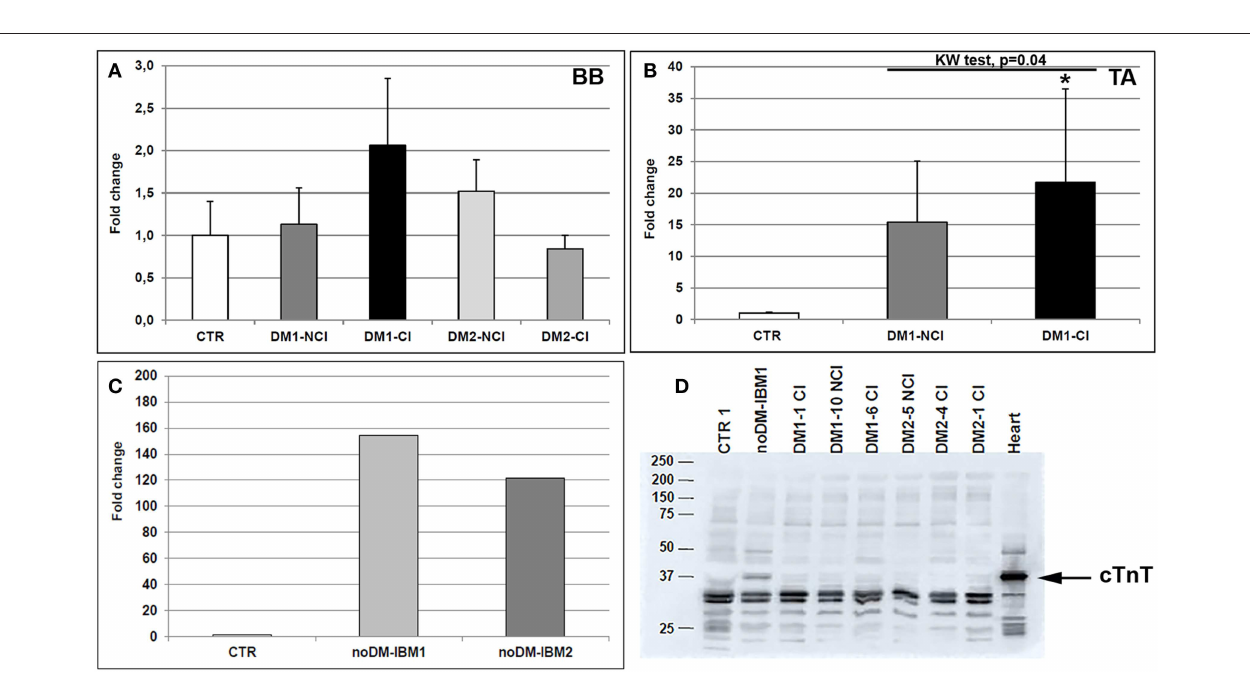
FIGURE 2 | (A–D) mRNA and protein TNNT2 expression in skeletal muscle. TNNT2 gene expression measured by qRT-PCR in biceps brachii (BB) muscle samples (A) and tibialis anterior (TA) muscle samples (B) from CTR (BB = 6; TA = 4), DM1 (BB = 12; TA = 12), and DM2 (BB = 9) patients. DM1 and DM2 patient groups have been divided into two subgroups according to the presence of cardiac abnormalities: NCI, no cardiac involvement; CI, cardiac involvement. The expression level of TNNT2 has been quantified in skeletal muscle (vastus lateralis) of patients affected by inclusion body myositis (noDM-IBM) (C) . Histograms represent mean values and bars represent standard error of the mean (SEM). GAPDH has been chosen as the housekeeping, internal control. Each PCR reaction has been performed in triplicate. The differences between subgroups have been assessed by nonparametric, Kruskal-Wallis test. Results from Dwass, Steel, Critchlow – Fligner multiple post-hoc comparison procedure: NCI or CI subgroups vs. CTR, * p < 0.05. (D) Representative western blot analysis of cTnT protein expression (37 kDa) in muscle biopsies obtained from CTR, noDM-IBM, DM1, and DM2 patients. Whole protein extract from human heart auricula has been used as positive